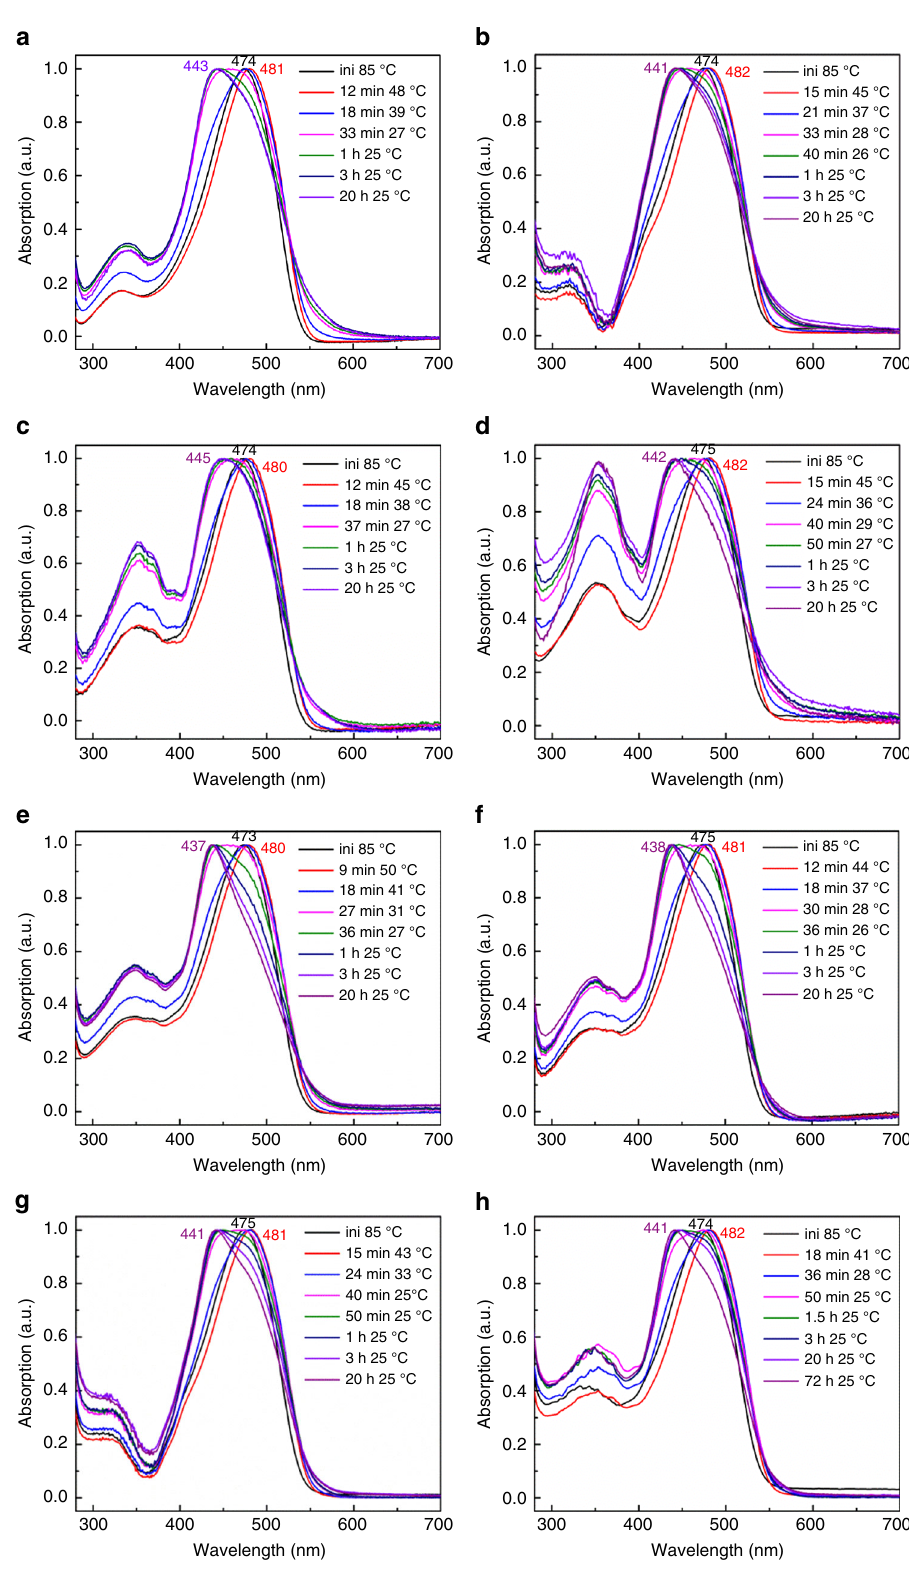
Fig. 5 UV-Vis absorption changes of PPV 12 - b -P2VP n in 2-PrOH solution. The varying UV-Vis absorption spectra of a PPV 12 - b -P2VP 12 in 0.01 mg mL − 1 2-PrOH solution; b PPV 12 - b -P2VP 12 in 0.0025mg mL − 1 2-PrOH solution; c PPV 12 - b -P2VP 16 in 0.01 mg ml − 1 2-PrOH solution; d PPV 12 - b -P2VP 16 in 0.0025 mg ml − 1 2-PrOH solution; e PPV 12 - b -P2VP 22 in 0.05 mg ml − 1 2-PrOH solution; f PPV 12 - b -P2VP 22 in 0.01 mg ml − 1 2-PrOH solution; g PPV 12 - b -P2VP 36 in 0.05 mg ml − 1 2-PrOH solution; and h PPV 12 - b -P2VP 36 in 0.01 mg ml − 1 2-PrOH solution. All the sample solutions were heated at 85